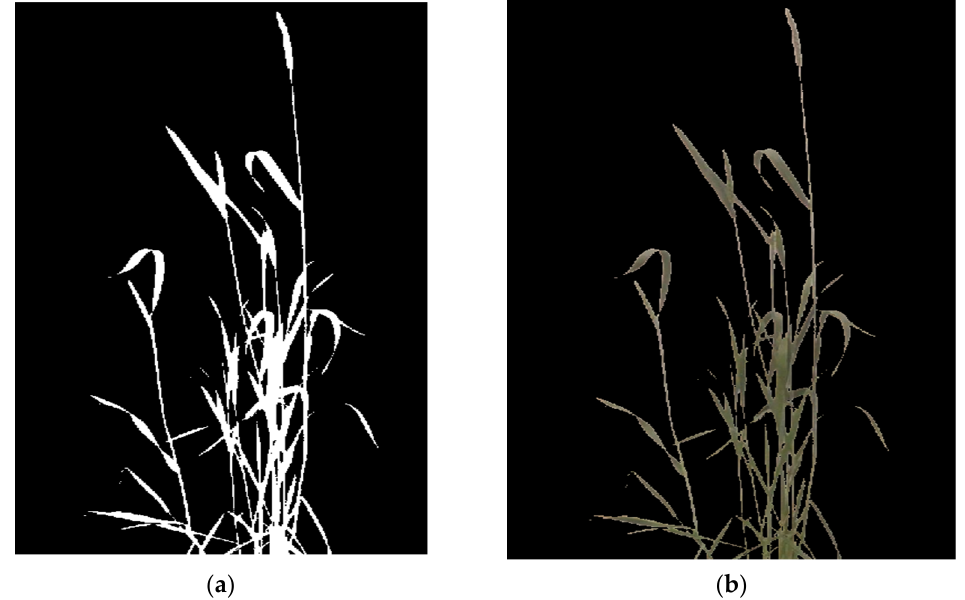
Figure 10. Image segmentation: ( a ) foreground mask after adaptive thresholding and ( b ) segmented RGB image after application of the foreground mask. The non − canopy pixel values are converted to zero.